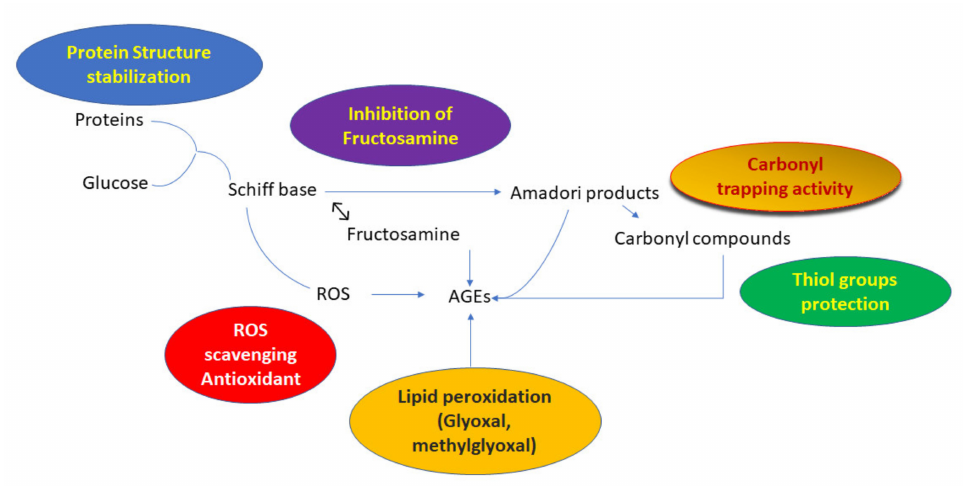
Figure 7. Mechasnidtic pathway of caffeic and coumaric acid to inhibit advanced glycation end- products